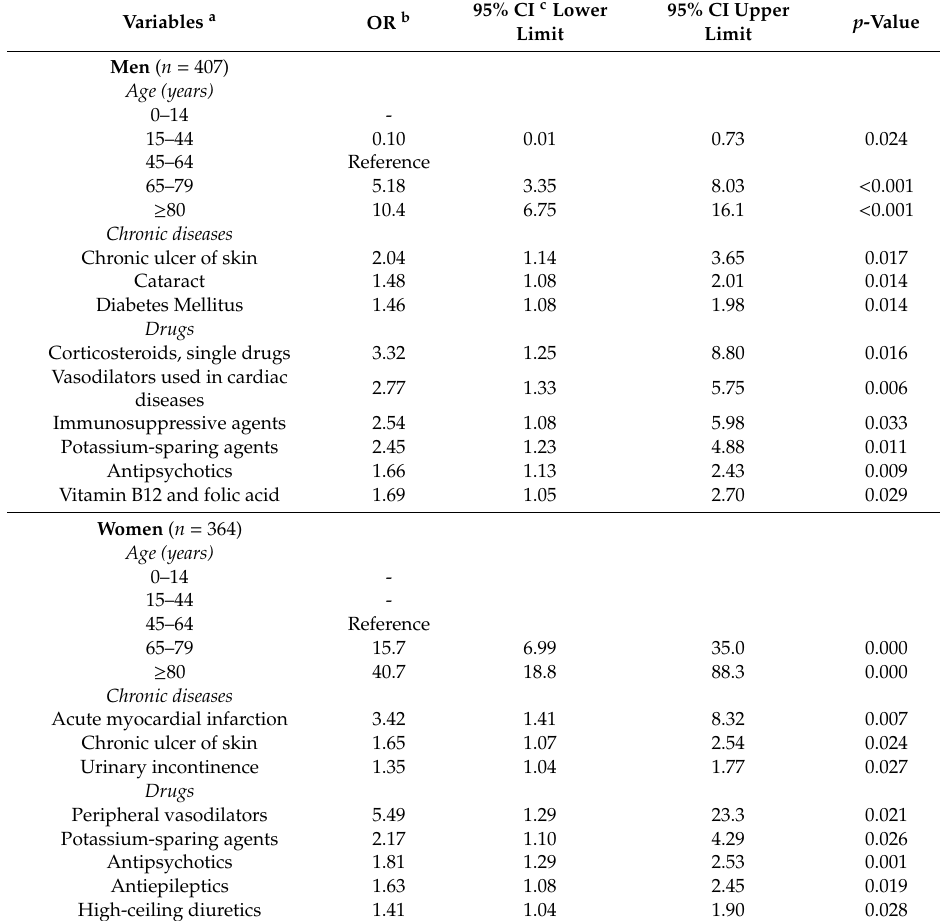
Table 4. Models of likelihood of mortality according to baseline demographic and clinical variables of the individuals with laboratory-confirmed infection by COVID-19, by